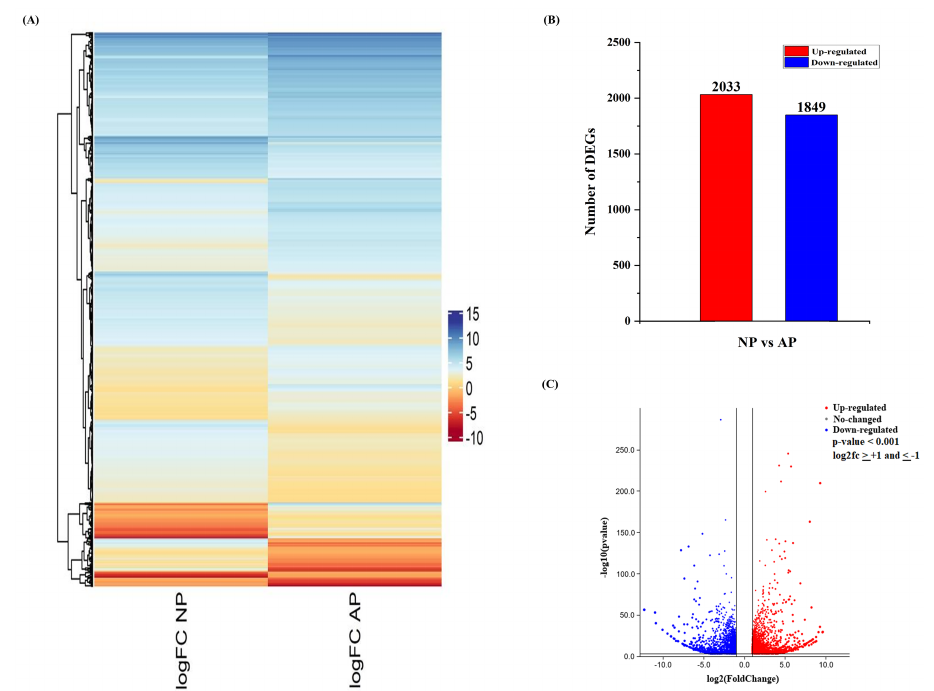
Figure 1. An overview of di ff erentially expressed genes (DEGs) involved in normal and abortive Figure 1. This is a figure, Schemes follow the same formatting. If there are multiple panels, they should be listed as: ( a ) Description of what is contained in the first panel. ( b ) Description of what is contained in the second panel. Figures should be placed in the main text near to the first time they are cited. A caption on a single line pistils of Japanese apricot. ( A ) Heatmap showing the di ff erential expression pattern of the DEGs. should be centered. The color scale shows the gene expression values (log2fc). ( B ) Up- and down-regulation of di ff erentially expressed genes. ( C ) Volcano plot showing the di ff erentially expressed genes. The x-axis represents the log2 fold change conversion of the values, and the y-axis represents the significance value after –log10 conversion. Red shows up-regulated DEGs, blue shows down-regulated DEGs, while grey represents no